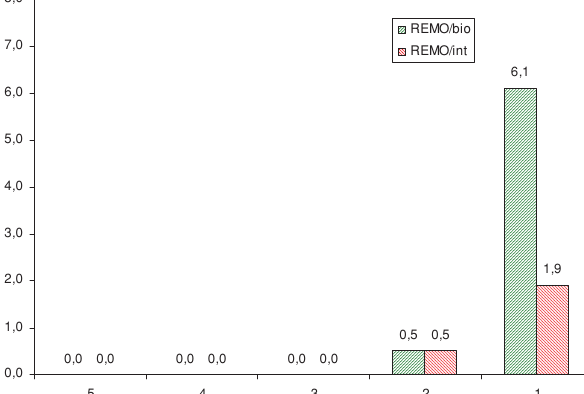
Figure2. Number of inflorescences on the fruiting structures of different age on the variety PILOT depending also on the growing technology ( Debrecen- Pallag, 2010)